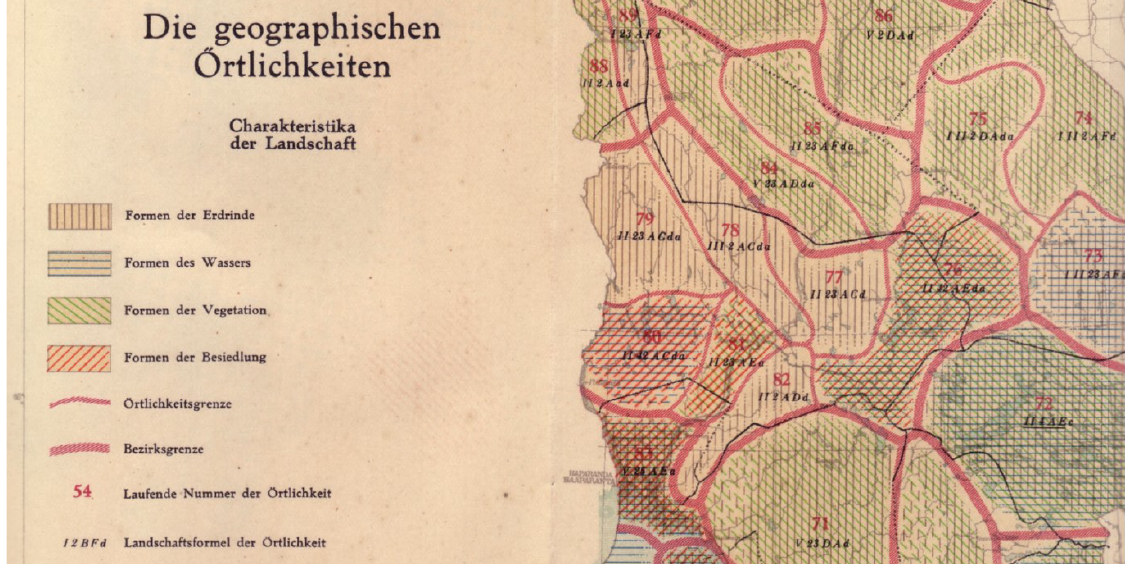
Figure 4: Portion of „Die geographischen Gebiete Finnlands“ [„The Geographic Regions of Finland“], original scale 1:3,000,000 (Granö,